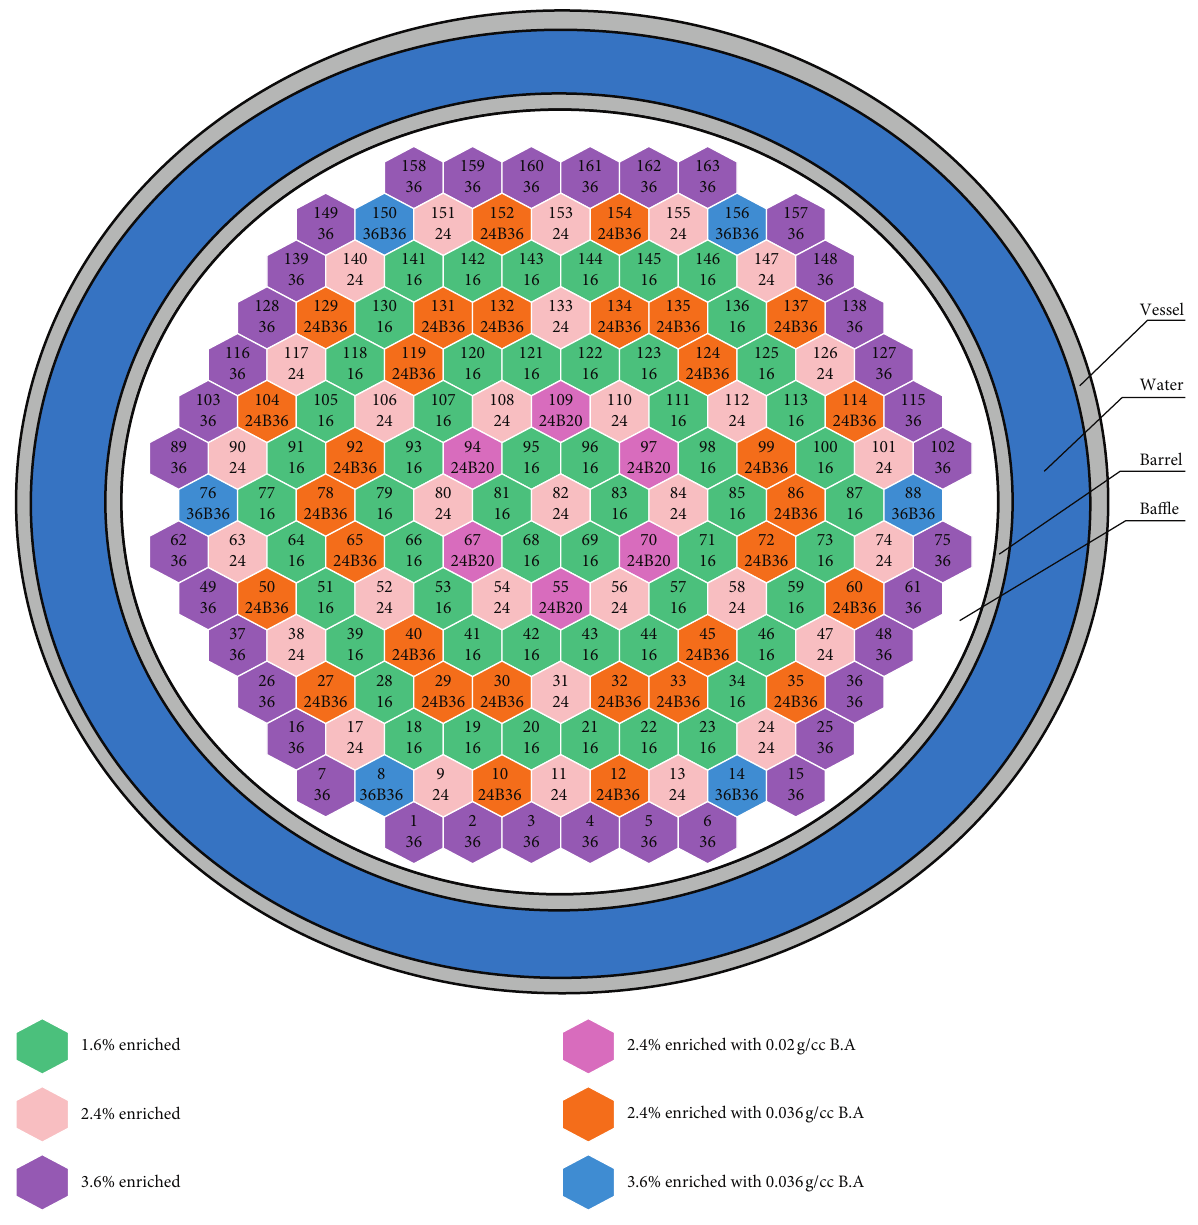
Figure 1: Core loading pattern for the first cycle at beginning of cycle (BOC) (v) Cross sections of (n, n’) and (n, xn) : the ENDF/B- VIII evaluation for the total inelastic scattering cross section ( n , n ’) is slightly decreased than the last ENDF/B-VII.1 evaluation. ENDF/B-VIII valuation for the ( n , xn ) secondary neutron was not changed but showed a difference above 14 MeV. (vi) Nubar : evaluators used the parameter nubar to study criticality problems since criticality is highly sensitive to nubar. Several simulations have shown that the use of the new PFNS and TNCs of ENDF/B- VIII produces marginally higher k values than eff those of ENDF/B-VII.1 [17, 18].